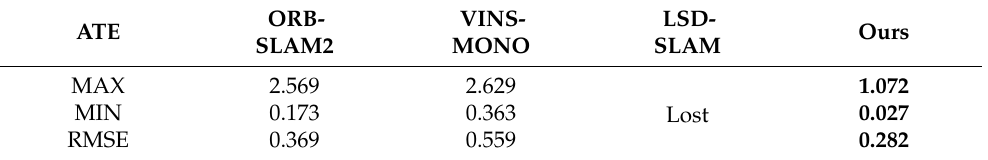
Table 3. Comparison of ATE among algorithms. Bold numbers represent the best performances.